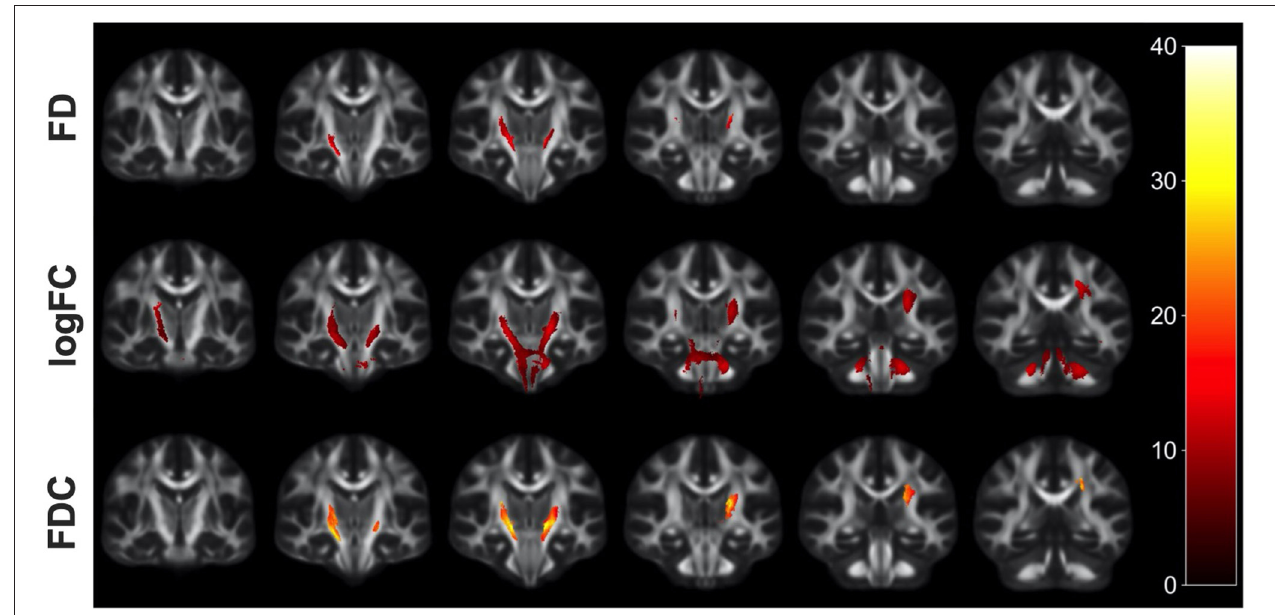
FIGURE 1 | Fiber tract-specific reductions in HIV + compared to HIV– using whole-brain FBA. Significant fixels (FWE-corrected p -value) between HIV + and HIV– groups displayed as the percentage decrease in the HIV + group compared to healthy controls, displayed in coronal slices. FD, fiber density; logFC, fiber bundle cross section; FDC, fiber density and cross